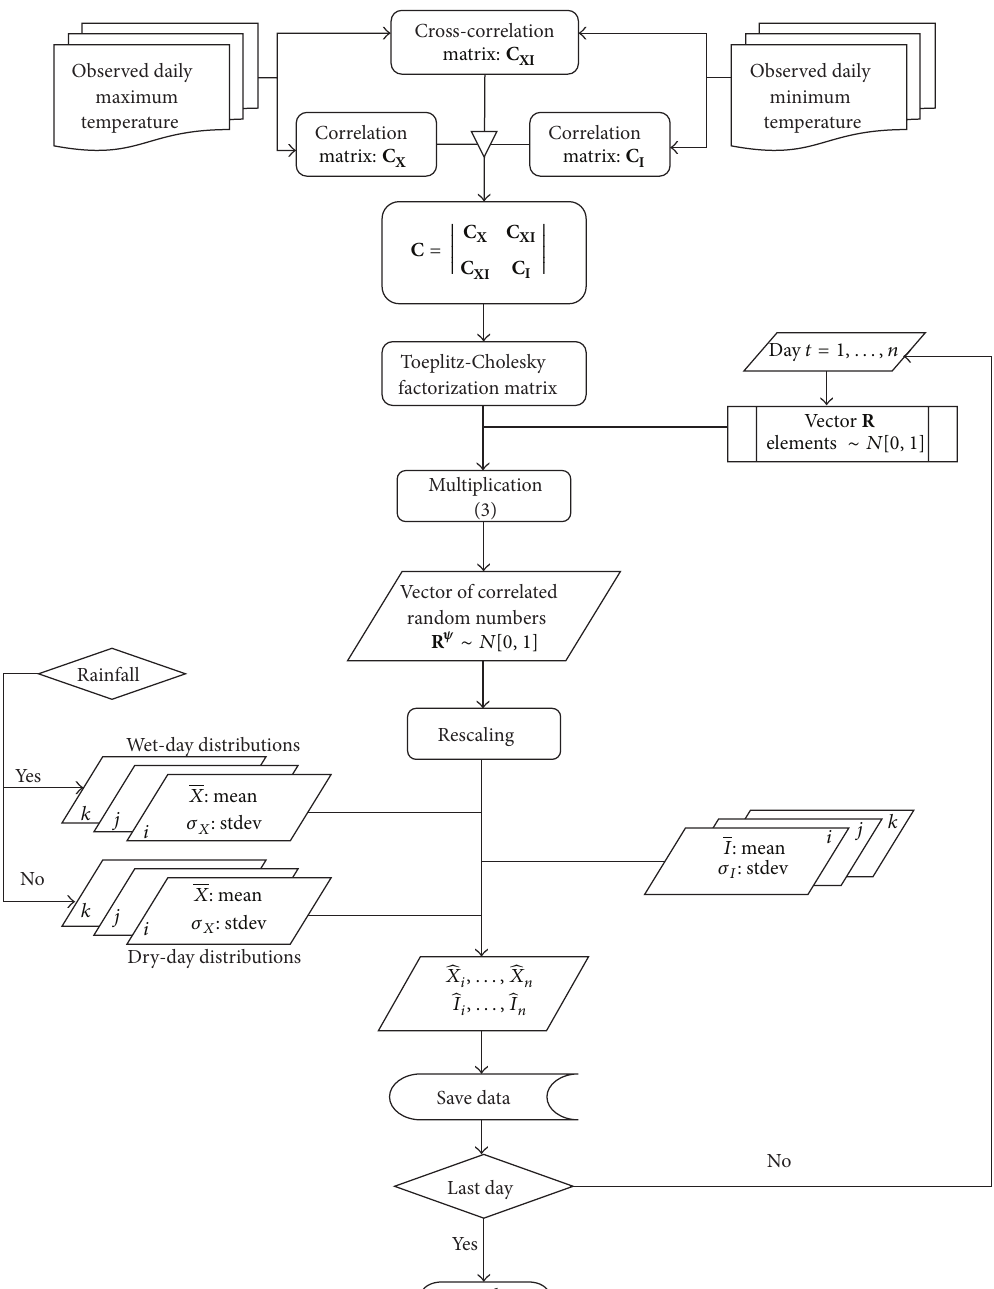
Figure 3: Flow diagram detailing the sequence of processes to generate maximum and minimum temperatures following the third model.